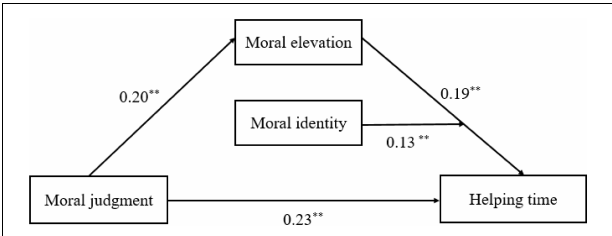
moral elevation to prosocial behavior were significant ( B = 0.18,